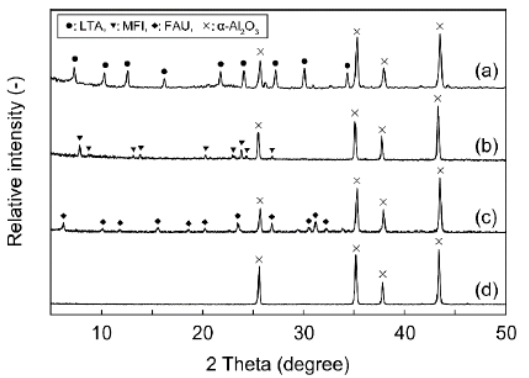
Figure 3. Schematic illustration of zeolite structures and SEM images of fractured sections of ( a ) LTA-, ( b ) MFI-, and ( c ) FAU-type zeolite membranes.